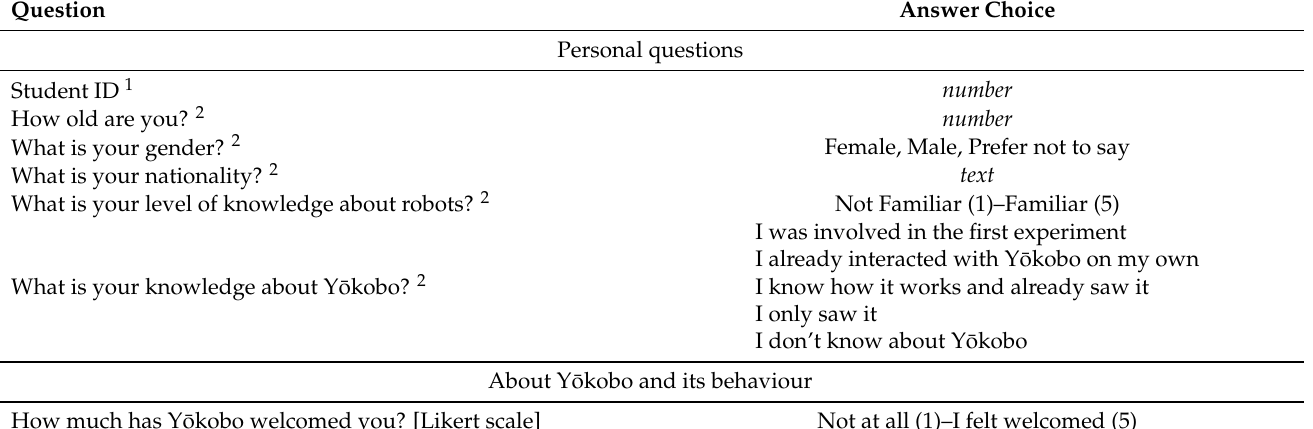
Table A1. Questions asked in QS, QW1, and QW2. The text in square brackets was added for this article and was not present in the questionnaire.